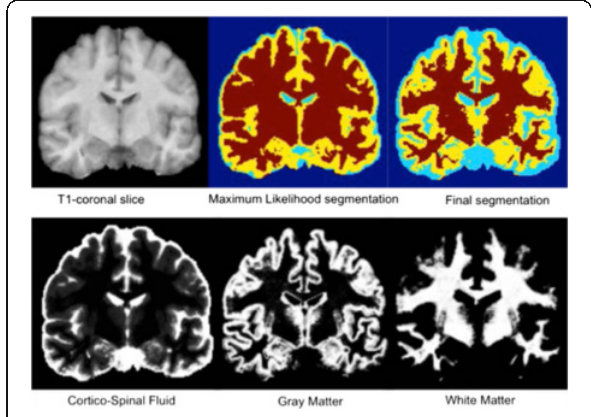
Fig. 21 (abstract A23). Example segmentations on T1 images